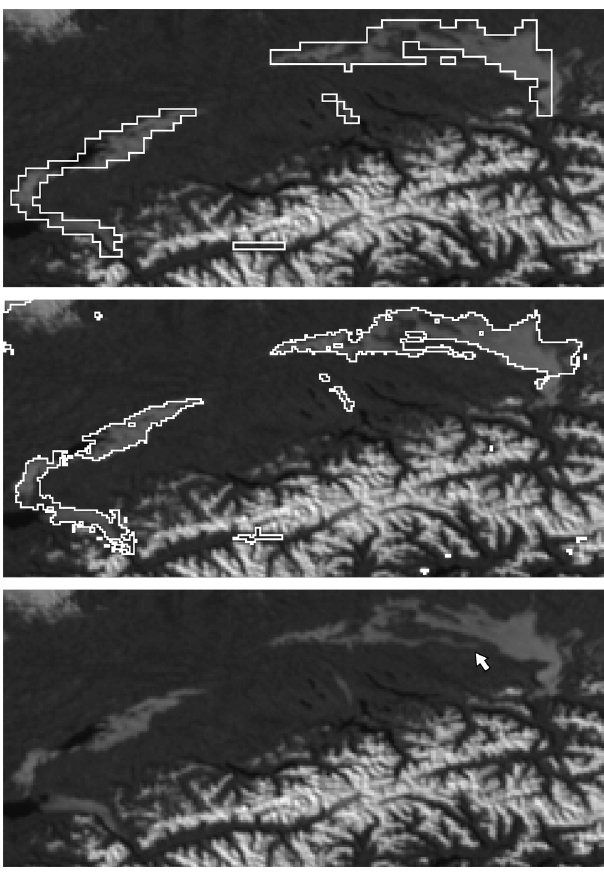
Fig. 8. 3km (top) and 1km (middle) FLS mask for fog in Southern Germany and Switzerland on 17 January 2011. White line = boundary of the masks. White arrow = detail that strongly benefits from the resolution